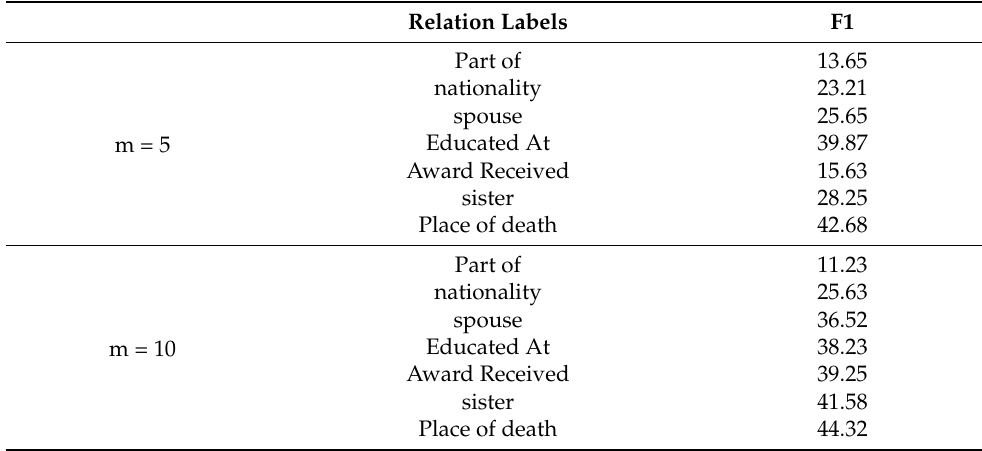
Table 10. Separate evaluation on relation